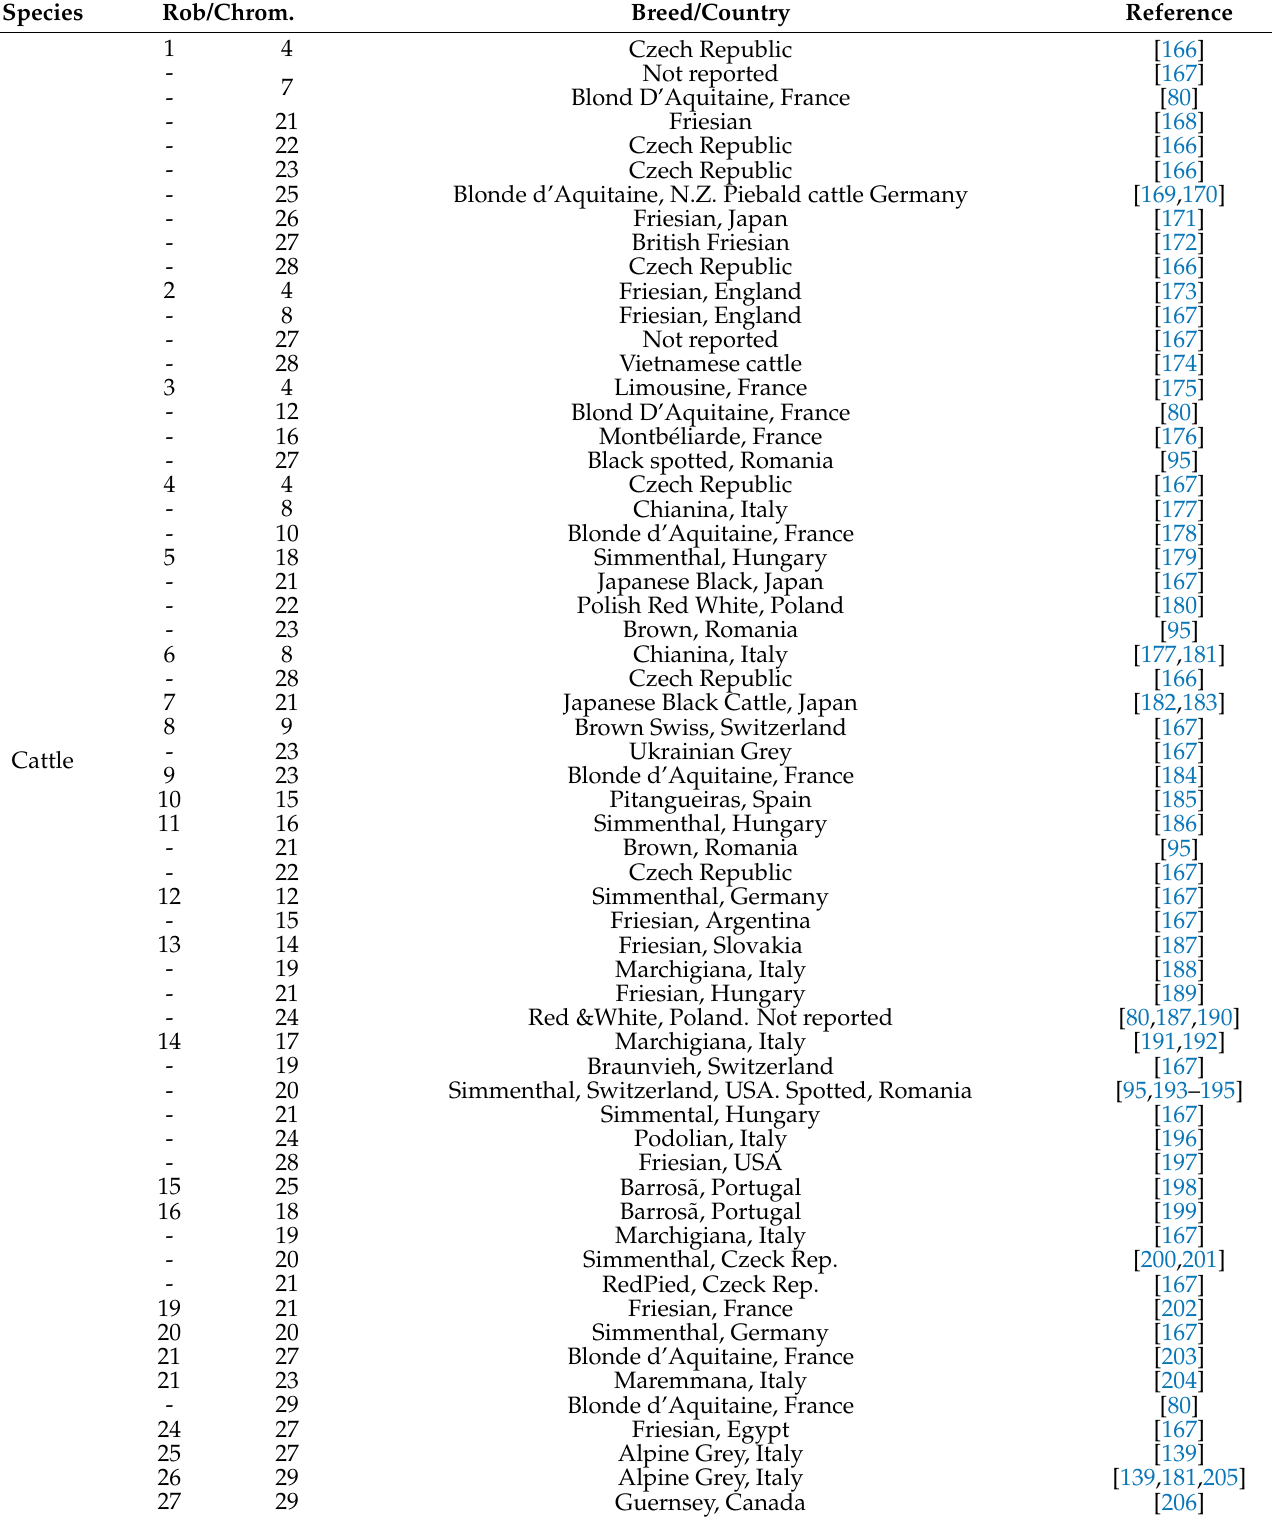
Table 8. Dicentric Robertsonian translocations reported in cattle, river buffalo, sheep, and goat. Species